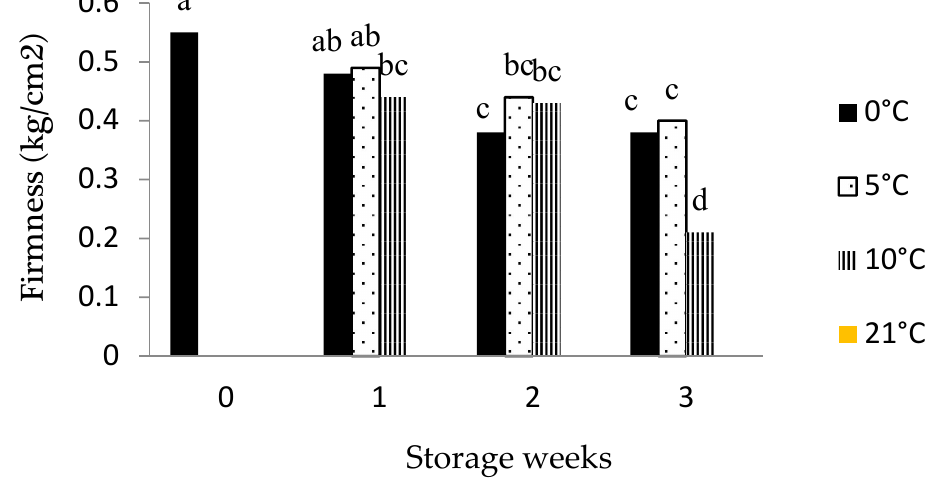
Figure 1. Effects of different storage temperatures on the fruit firmness of cornelian cherries treated with 1% chitosan. Different letters on bars indicate significant differences among storage tempera- tures at p < 0.01 by Duncan’s test.